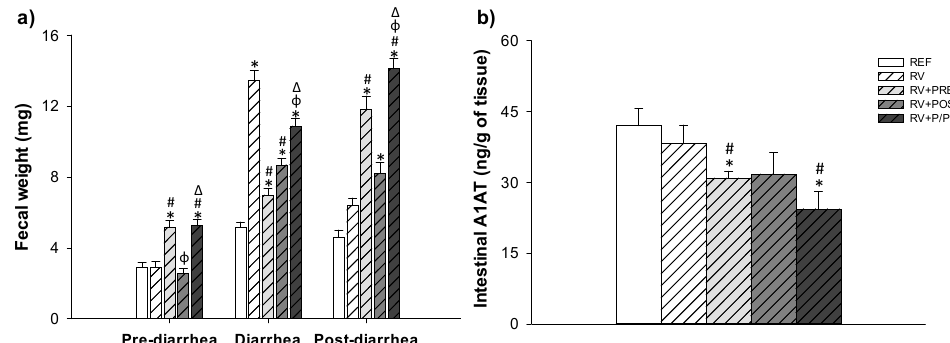
Figure 4. Fecal weight (mg) ( a ) and intestinal barrier permeability ( b ). The fecal weight was grouped in the pre-diarrhea, diarrhea, and post-diarrhea periods ( a ). The pre-diarrhea lasts from day 0 to day 5, diarrhea from day 6 to day 9, and post-diarrhea period from day 10 to day 16. Results are expressed as mean ± SEM ( n = 24 animals/group). Statistical differences: * vs. REF, # vs. RV, φ vs. RV + PRE, ∆ vs. RV + POST. REF: reference group; RV: rotavirus group; RV + PRE: rotavirus group supplemented with a mixture of scGOS/lcFOS; RV + POST: rotavirus group supplemented with Lactofidus TM ; RV + P/P: rotavirus group supplemented with the combination of